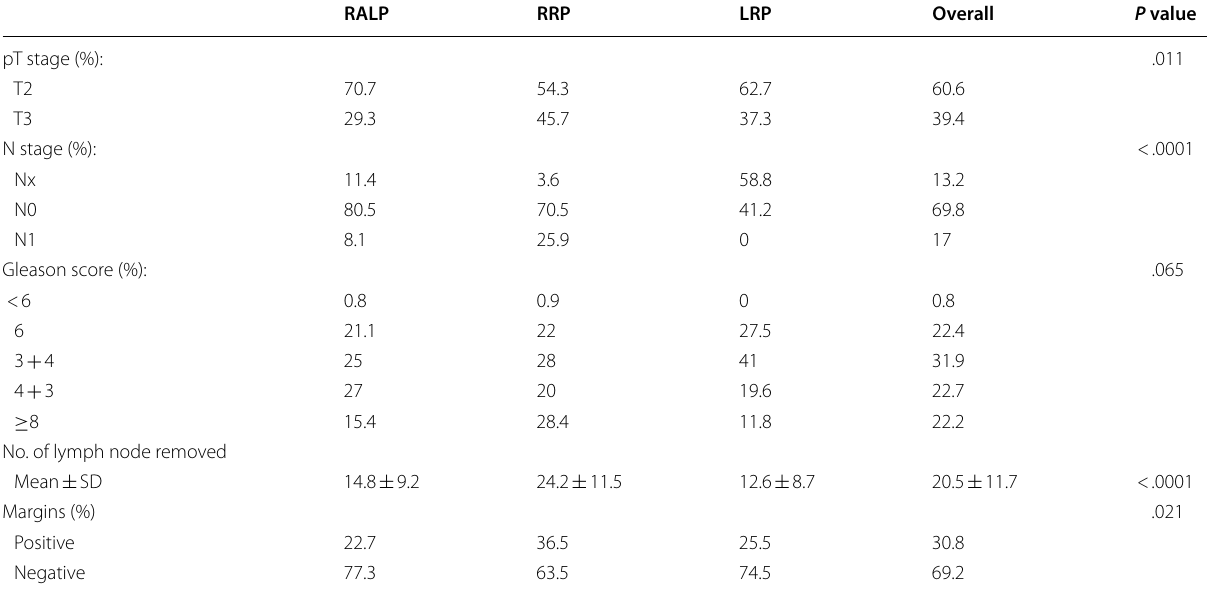
Table 3 Postoperative pathological